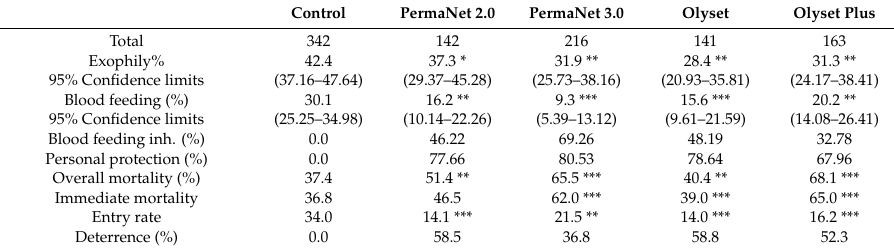
Table 3. Results of the performance of the four brands of LLINs against wild Mansonia spp. in experimental